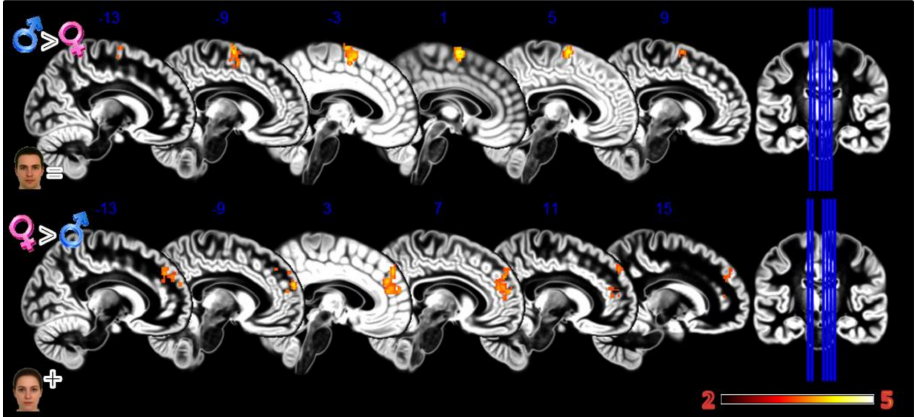
Figure 4. Group differences for the Static Morphing experiment. First row Males greater than Females for looking at own face, second row Females greater than Males for looking at feminized faces. In red significant clusters ( p corr < 0.05) on a gray matter ICBM brain template, neurological convention, color scale in the bar maps for Z scores. In blue MNI coordinates in mm, and lines to show the slice positions on the orthogonal projections (right side of the figure).